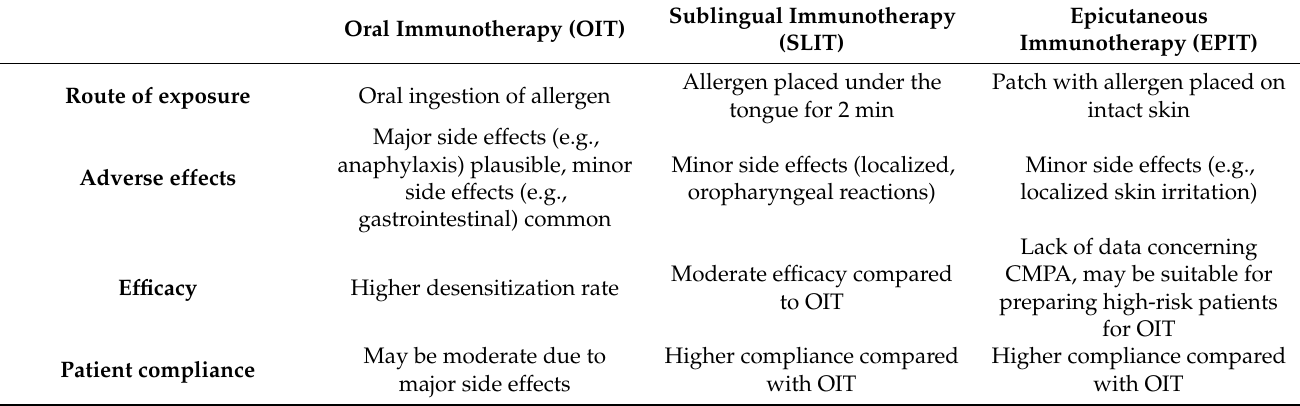
Table 3. Main features of different types of immunotherapy (modified from Barni S. et al. [29]). Oral Immunotherapy (OIT) Route of exposure Oral ingestion of allergen